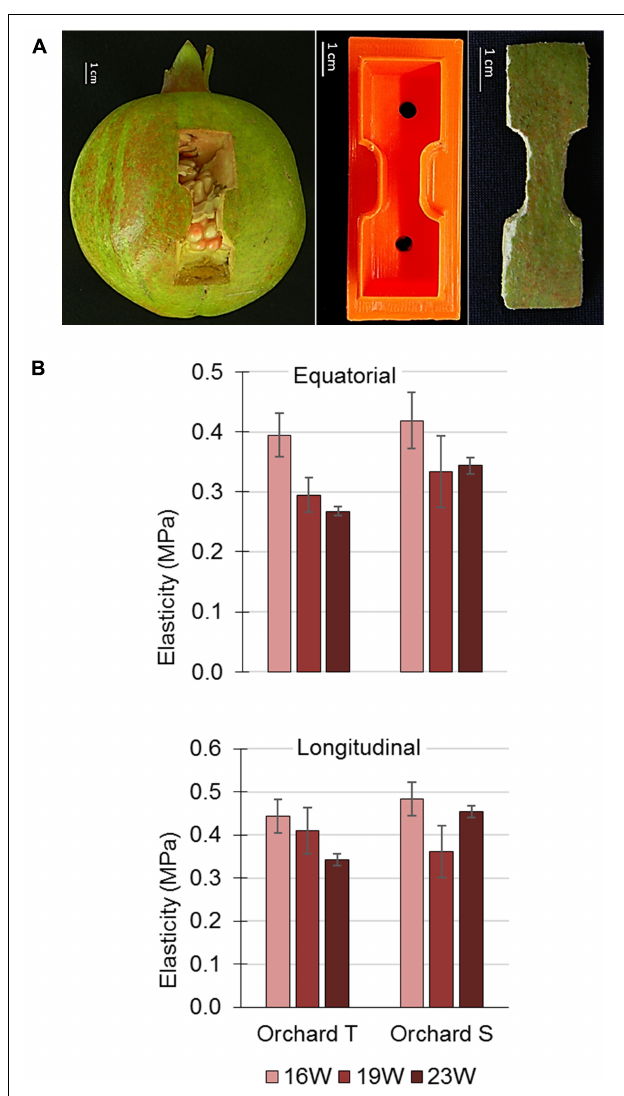
FIGURE 7 | Elasticity of pomegranate peel during the second half of the 2017 growing season. (A) Illustration of longitudinal peel sampling for clamping in the Universal Testing Machine (left panel). For the experiment, two equatorial and two longitudinal peel strips were collected similarly from each fruit. The peel samples were shaped using a plastic mold (middle panel) with sharp edges into strips of 6 cm lengthwise and 2 cm width, with a 2-cm long middle region of 1 cm width (right panel). (B) Elasticity of fruit peel from orchards S and T. Data from each orchard and time point are an average of 5 fruit with ±